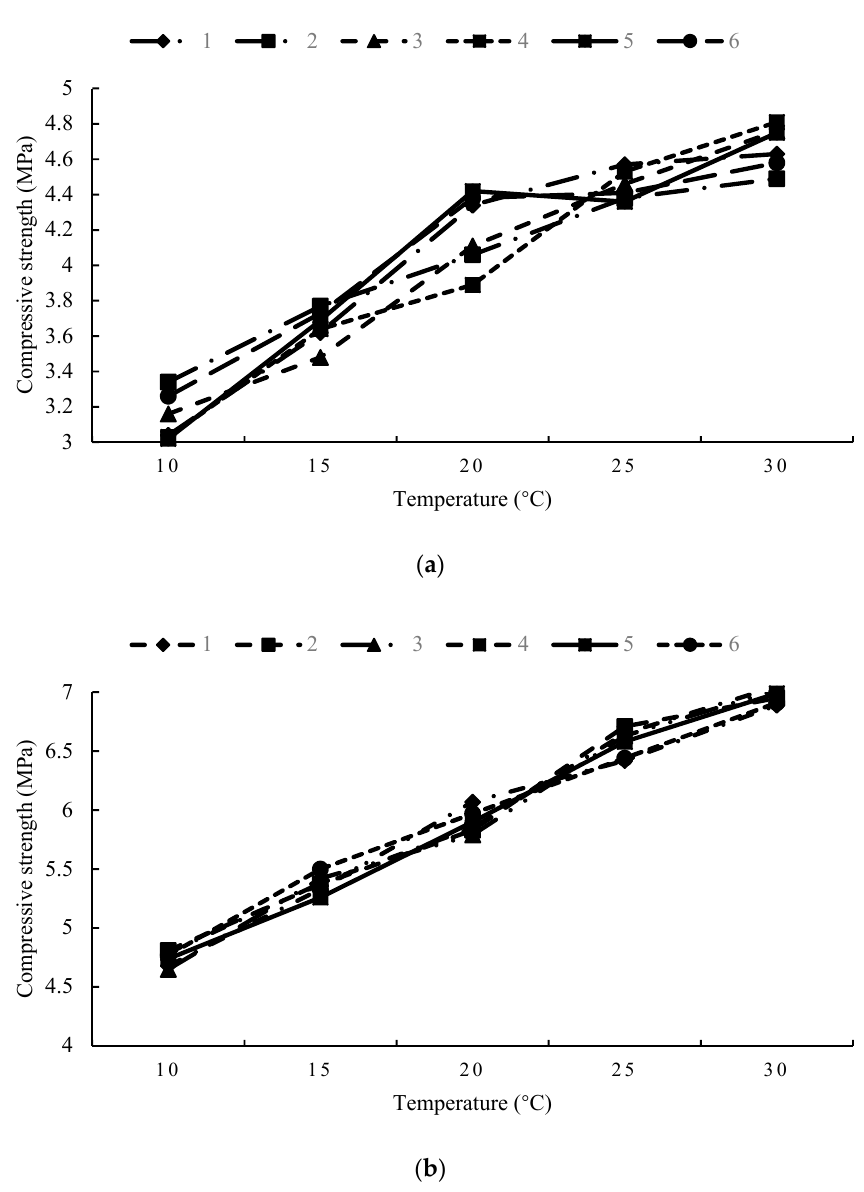
Figure 4. Compressive strength under different test procedures: ( a ) Relationship between temperature and compressive strength after 7 days of curing; ( b ) relationship between temperature and compressive strength after 28 days of curing.